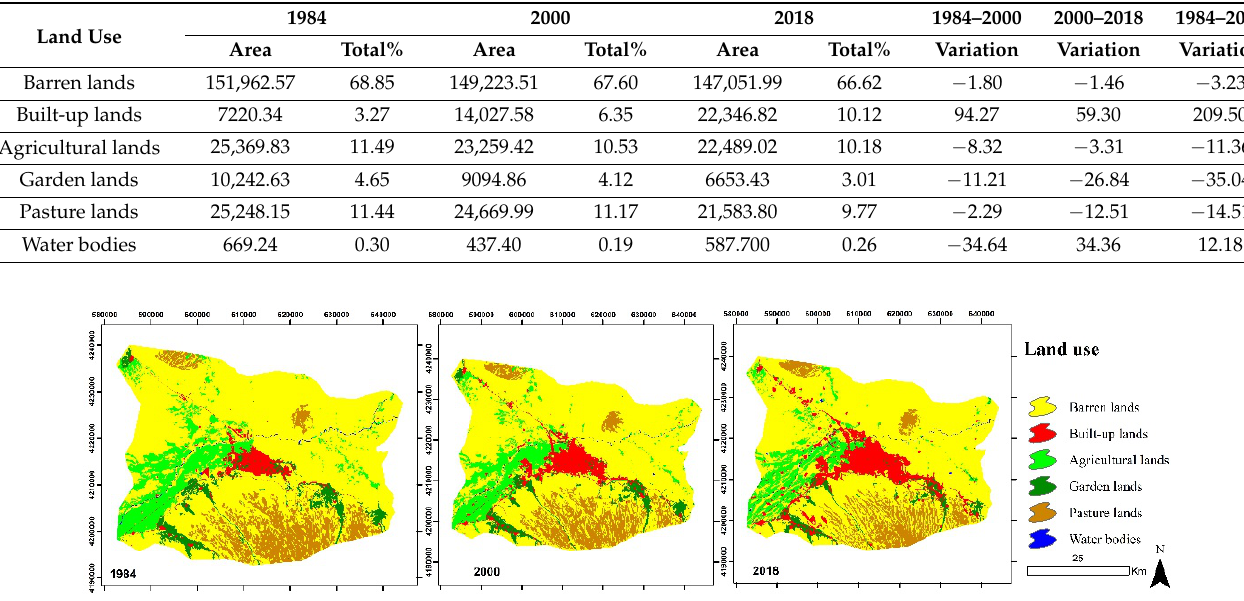
Table 2. Land use quantitative and structural changes in the TMA, 1984–2018 (unit: Ha).